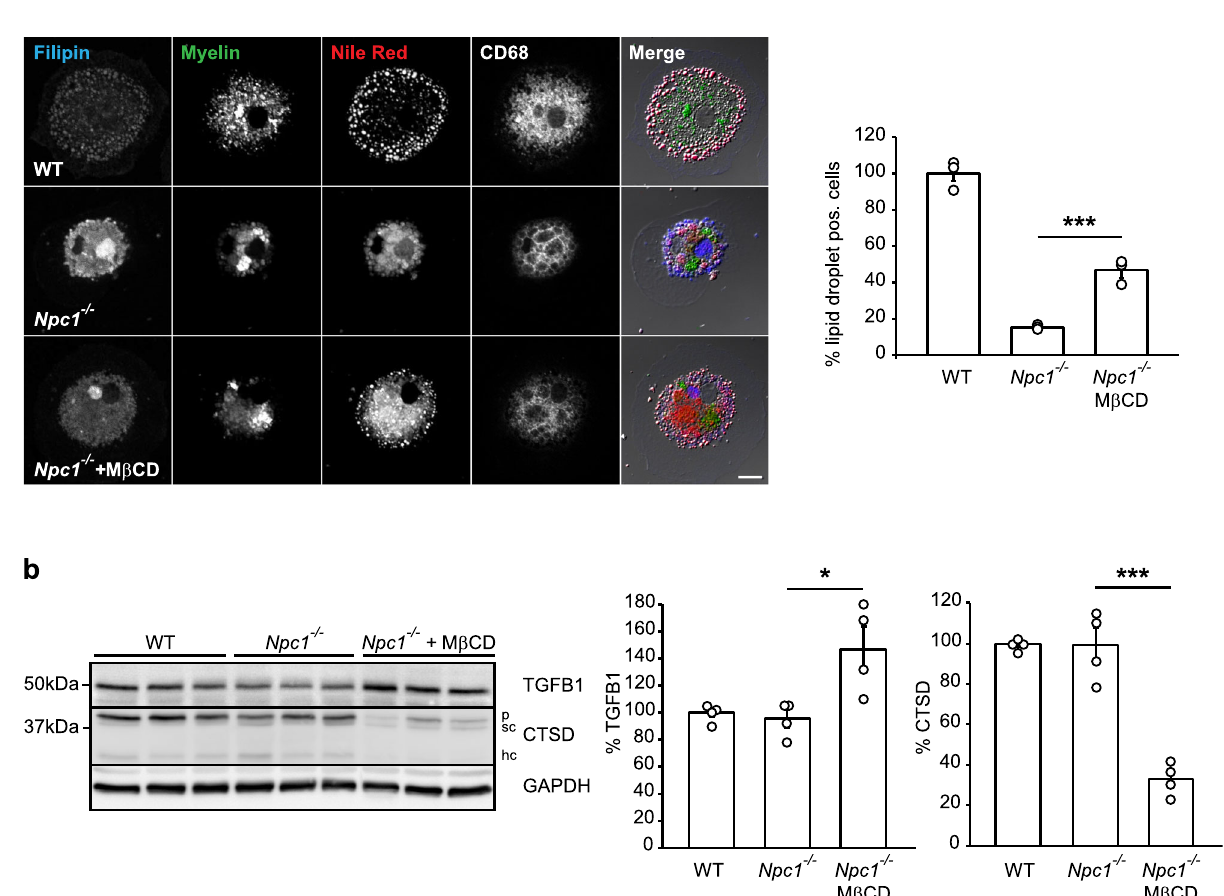
Fig. 7 Lowering cholesterol in Npc1 − / − microglia rescues lipid droplet phenotype. a M β CD treatment (48 h) of cultured Npc1 − / − microglia isolated from P7 mice and fed with fl uorescently labeled myelin (green) partially restored the formation of lipid droplets as visualized by Nile red (red). Filipin dye (blue) and an anti-CD68 antibody (white) were used to visualize cholesterol and late endosomal/lysosomal compartments, respectively. Scale bar: 10 μ m. Cells showing Nile red positive structures at cell periphery were quanti fi ed as lipid droplet positive cells. Three independent experiments were analyzed by confocal microscopy ( n = 3, p = 0.0003, one-way ANOVA followed by unpaired two-tailed Student ’ s t -test). b Western blot analysis and quanti fi cation of TGFB1 and CTSD ( p = pro-form; sc = single chain form; hc = heavy chain form) in cultured Npc1 − / − and WT microglia isolated from P7 mice. At 5DIV, Npc1 − / − cells were treated with 250 µ M M β CD for 48 h. GAPDH was used as a loading control. Protein levels were quanti fi ed by densitometry (ImageJ — NIH) from four independent experiments. Values were normalized on WT control and represent mean ± SEM (one-way ANOVA followed by unpaired two- tailed Student ’ s t -test). TGFB1 ( n = 4, p = 0.02); CTSD ( n = 4, p =